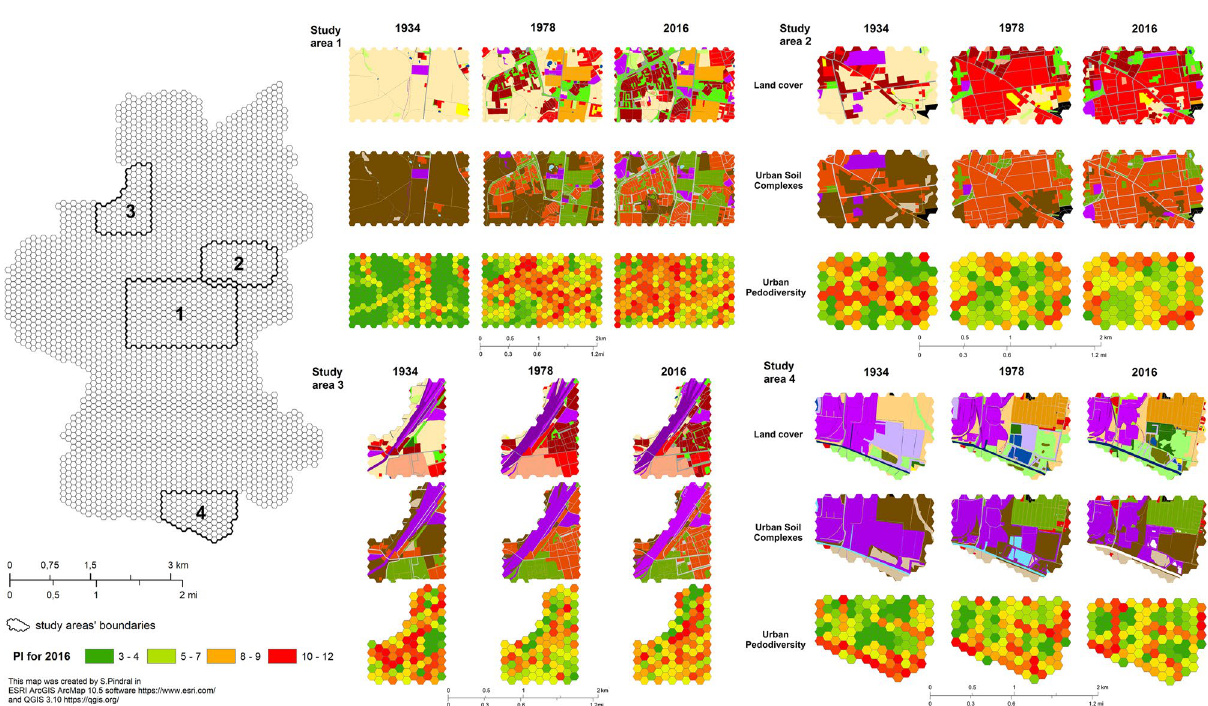
Figure 5. Patterns of urban pedodiversity changes according to land cover and urban soil complexes’